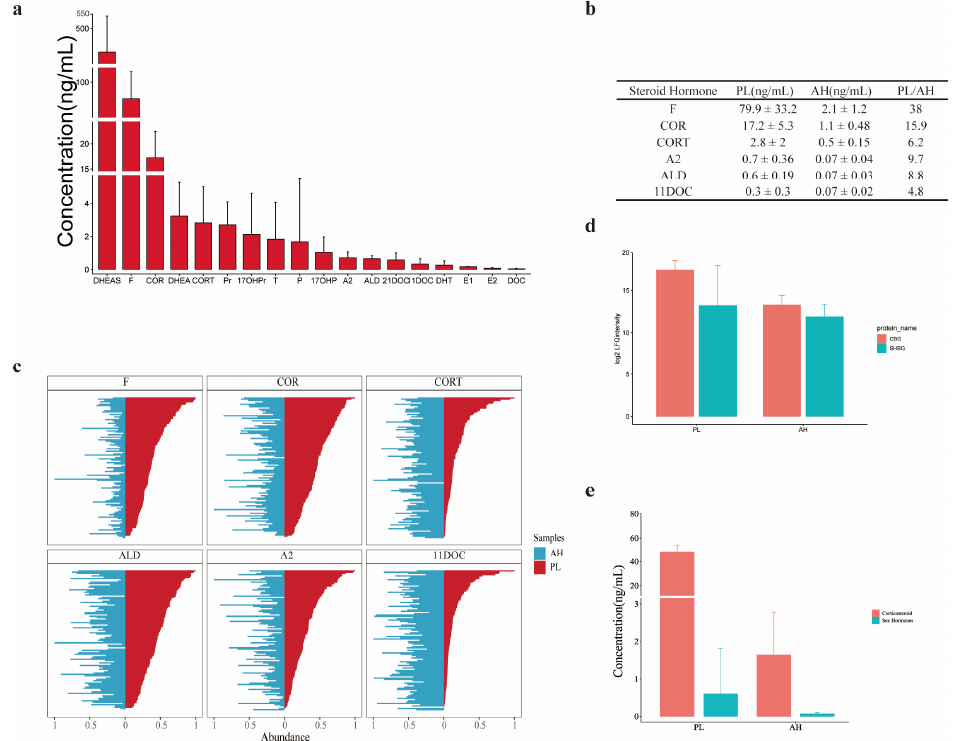
Figure 3. Comparison of steroid hormones in plasma and AH. ( a ) The abundance distribution of steroid hormones in plasmas in this study. ( b ) Table: The abundance of steroid hormones coidentified in plasma and AH in this study. ( c ) Individual comparison of the abundance ranking for the coidentified steroid hormones in plasmas and AHs in this cohort. ( d ) Comparison of the CBG and SHBG abundance between plasma and AH. ( e ) Comparison of the abundance sum of glucocorticoids or sexual steroid hormones between plasma and AH.